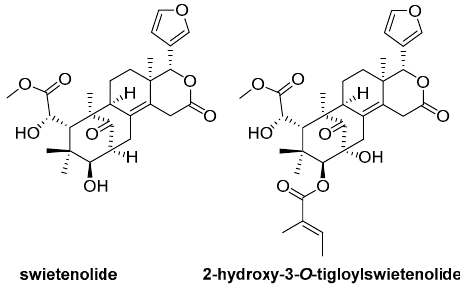
Figure 1. Structure of natural limonoids with antibacterial activity against multidrug resistance (MDR) bacterial strains.